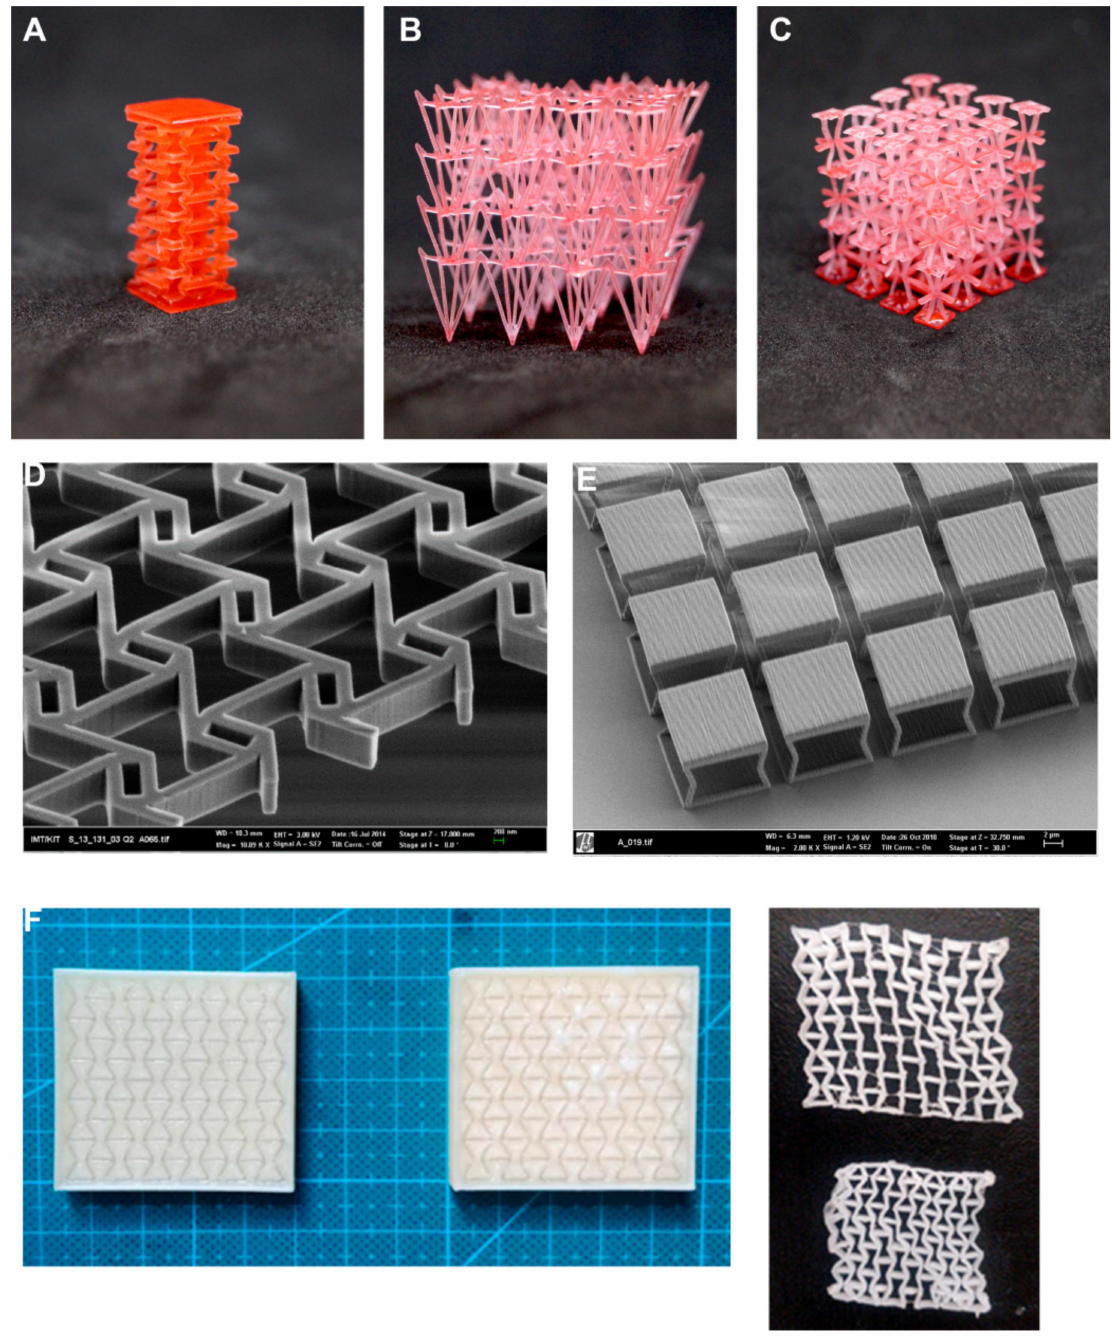
Figure 3. Examples of auxetics manufactured with different technologies and materials. ( A – C ) Three- dimensional auxetic made by laser stereolithography. ( D ) Deep reactive ion etching of silicon [43]. ( E ) Two-photo polymerization of metasurface with pixels supported by re-entrant pillars. Examples ( A – C ) were performed using Phrozen Transform Standard (Phrozen Ltd., Hsinchu, Taiwan) with HARZ Labs Basic Red resin (Moscow, Russia) specifically for the article. Examples D, E are manufac- tured with the support of the “Karlsruhe Nano Micro Facility, a Helmholtz Research Infrastructure” (for additional details, please check: [43,86,87]). ( F ) Soluble 3D printed PVA moulds and PDMS auxetic structures obtained by casting and mould dissolution, as indirect procedure to obtain auxetics (courtesy of Adri á n Mart í nez